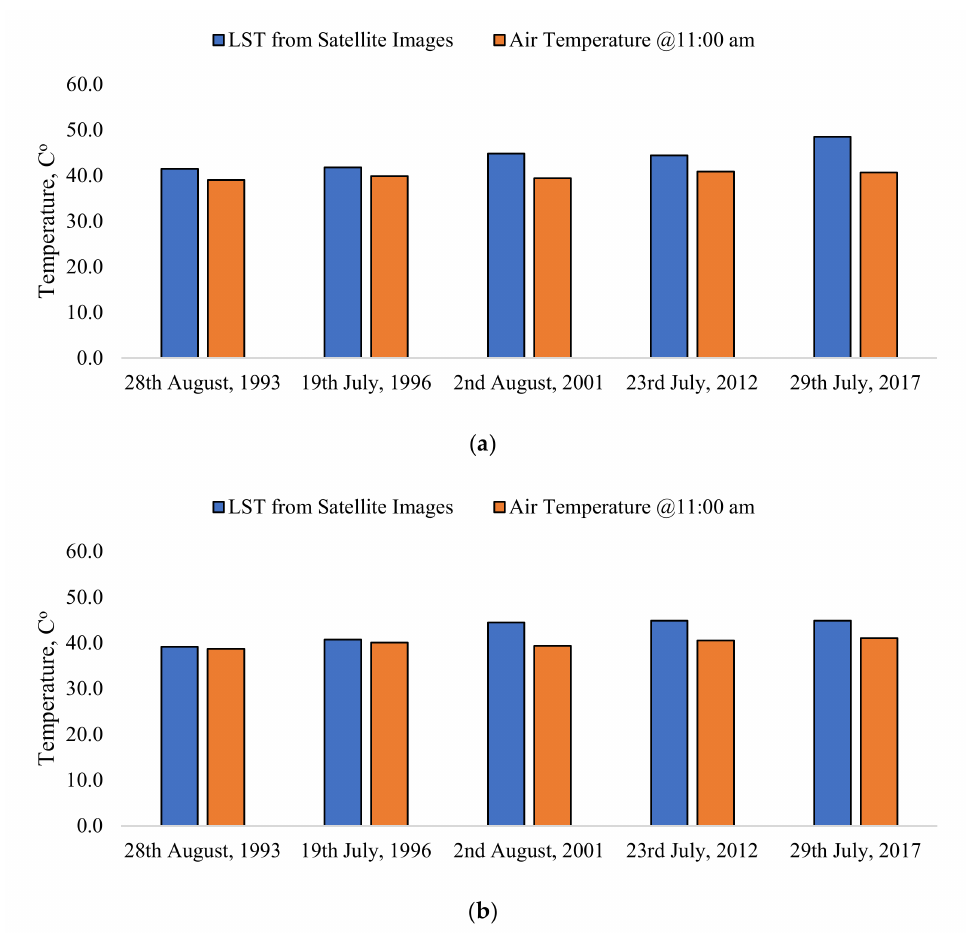
Figure 10. Temperature Difference between LST maps and Ground-truth Weather Stations. ( a ) Sharjah Airport; ( b ) Dubai